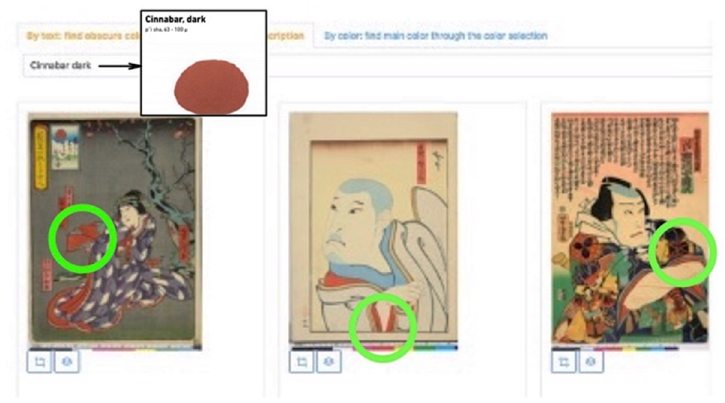
Figure 19. Demo application implementation. Figure 20. Retrieval results of inputting the pigment name ‘Cinnabar dark’.